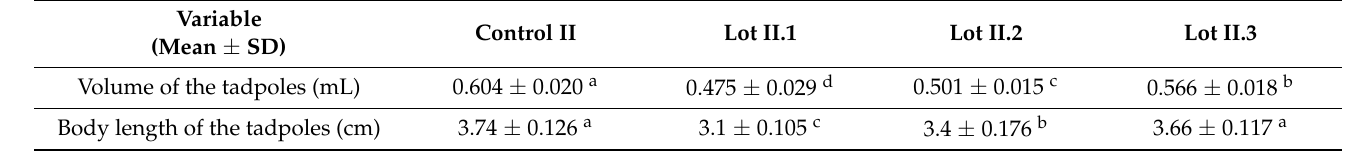
Table 10. Mean ± SD for volume and body length of Pelophylax ridibundus tadpoles upon Actellic 50 EC